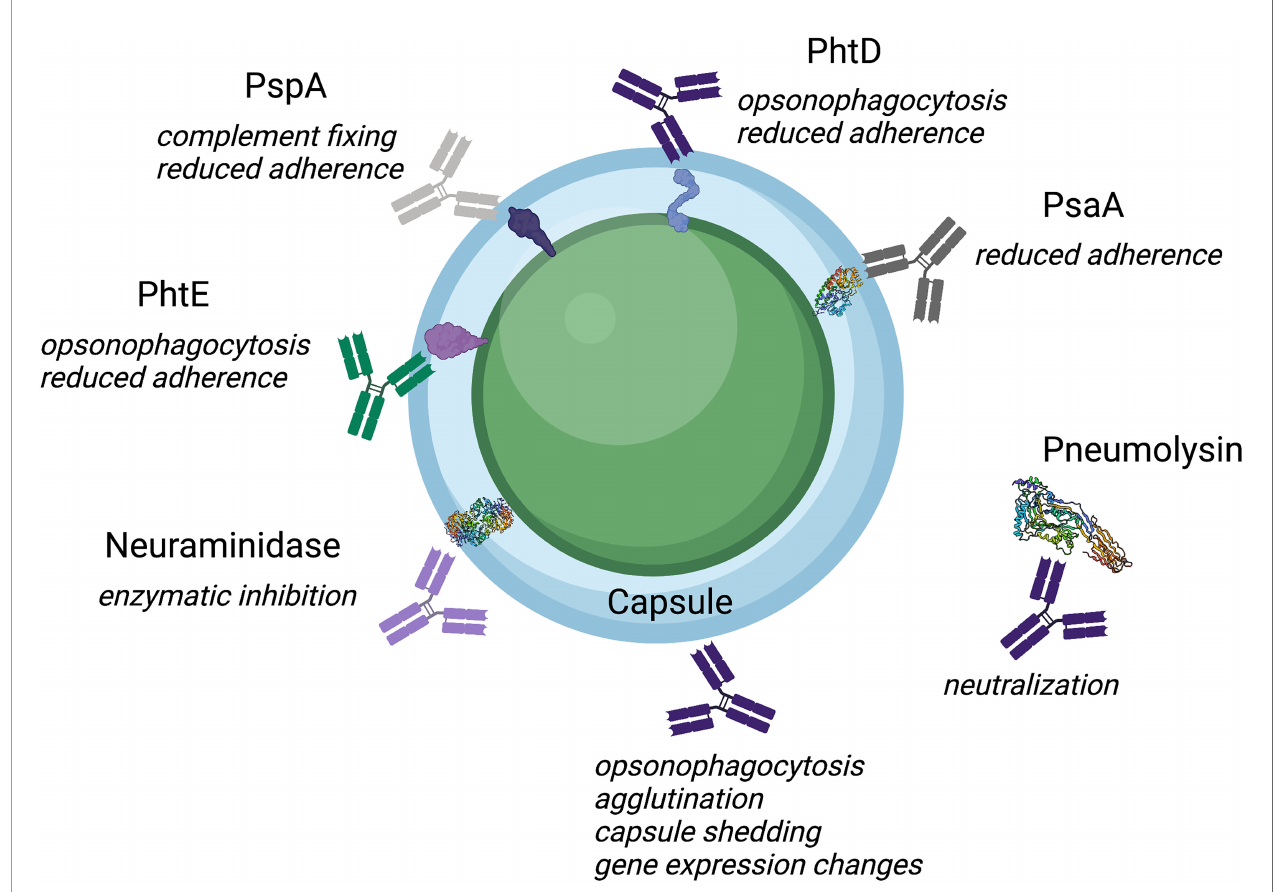
FIGURE 1 | Illustration of the diverse mechanisms and targets of anti-pneumococcal antibodies. Protein antigens are displayed within the capsule as cartoons or as protein models when available from the protein data